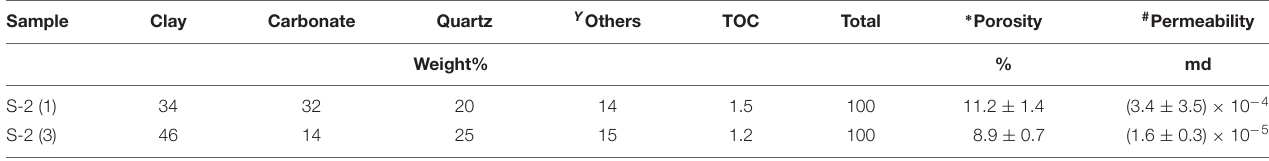
TABLE 1 | XRD mineral compositions combined with TOC and normalized to 100%. Sample